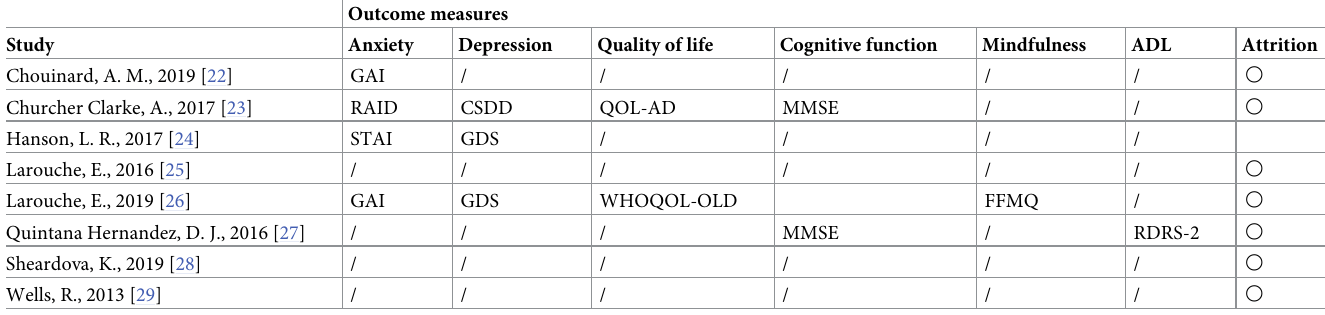
Table 2. Characteristics of included